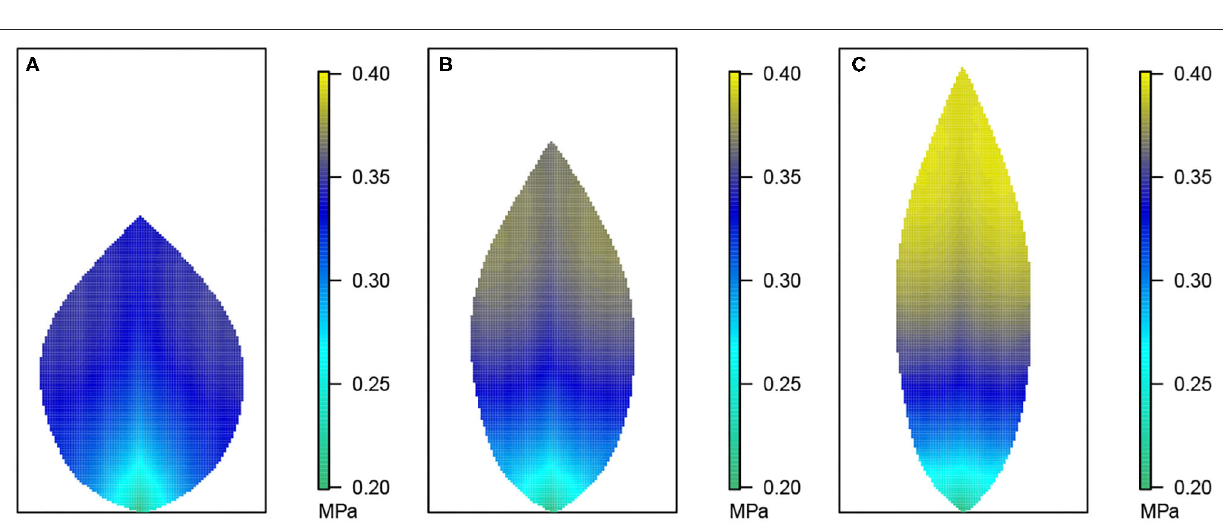
FIGURE 3 | Leaf area distributions of xylem hydraulic pressure. In this and the next three figures, (A) depicts the wide leaf, (B) shows the reference leaf, while (C) shows the narrow leaf distribution. In addition, second-order veins are 45 ◦ to the main vein (i.e., 45 ◦ to the reference state of perpendicular veins). Parameter conditions under which the simulations were performed are summarized in Table 3 and the core values in Table 4 .